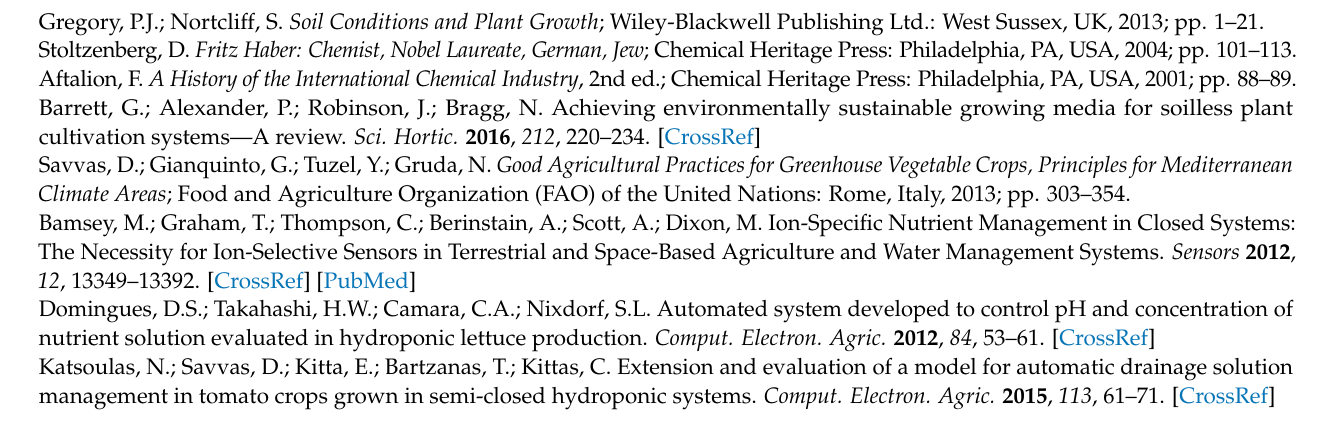
system, Figure S2: Separation of analyte ions using single ion-exchange group, Figure S3: Effect of (A) tartaric acid concentration and (B) 18-crown-6 concentration on the retention time of the analyte ions, Figure S4: Effect of (A) tartaric acid concentration and (B) 18-crown-6 concentration on the resolution of Na+, NH4+, and K+, Figure S5: Comparison of the analyte ion concentrations obtained from the developed method and the conventional ion-exchange chromatographic method. Table S1: Analyte performance under optimal conditions, Table S2: Analytical results for 12 fertilizer solution samples collected during the hydroponic